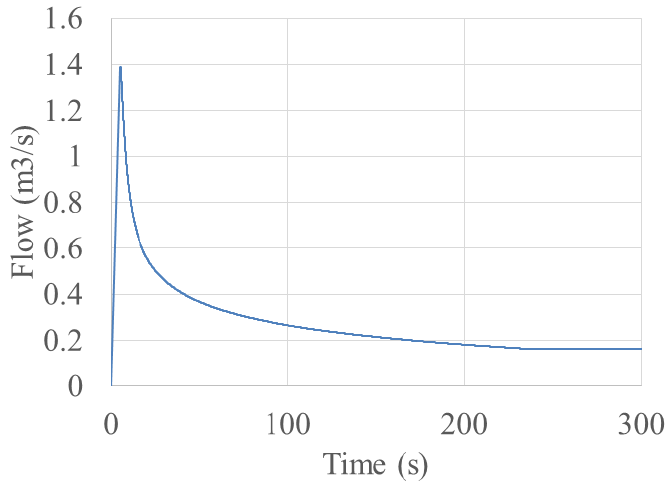
Figure 14. System flow rate time history.